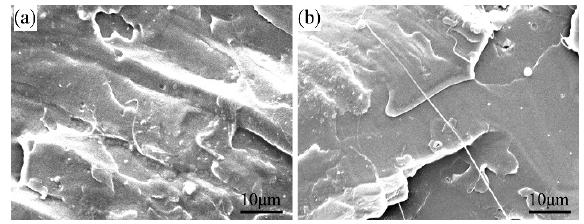
Figure 9. SEM images of ( a ) GO0.75/PLA and ( b ) KH560-GO0.75/PLA.